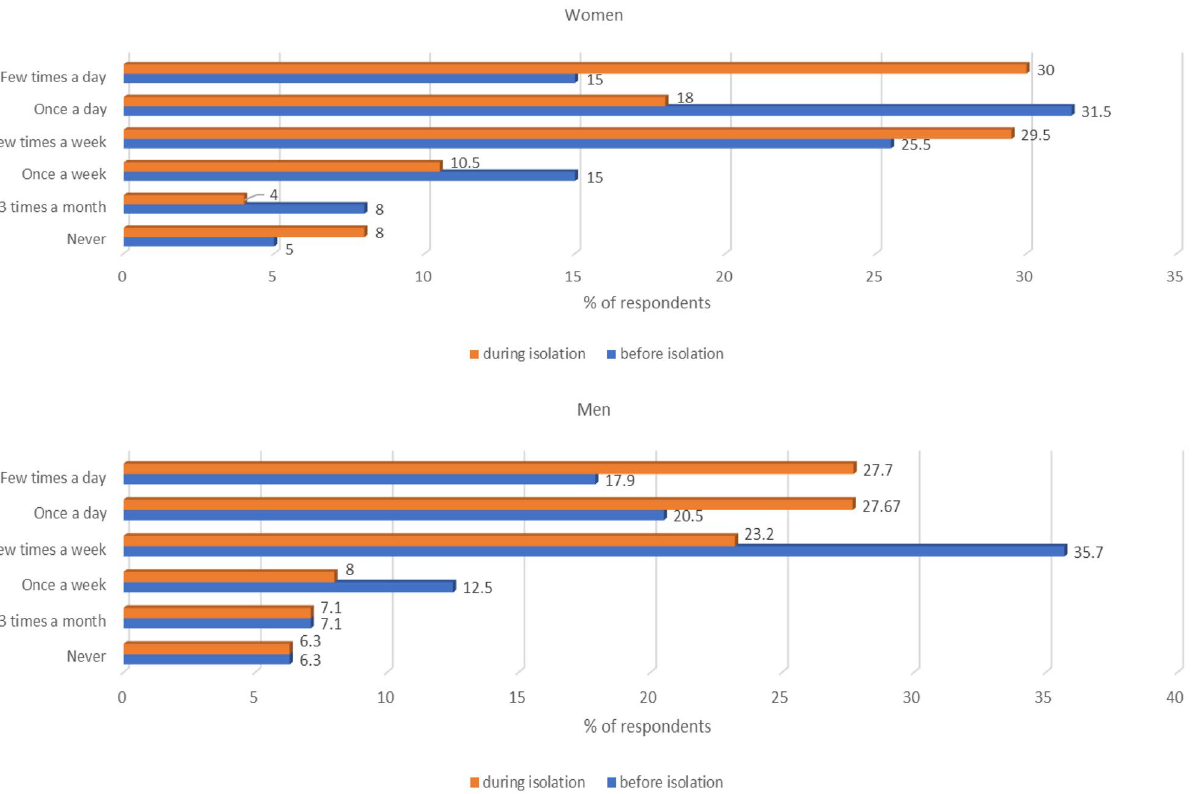
Figure 4. The frequency of snacking in a group of men and women before and during